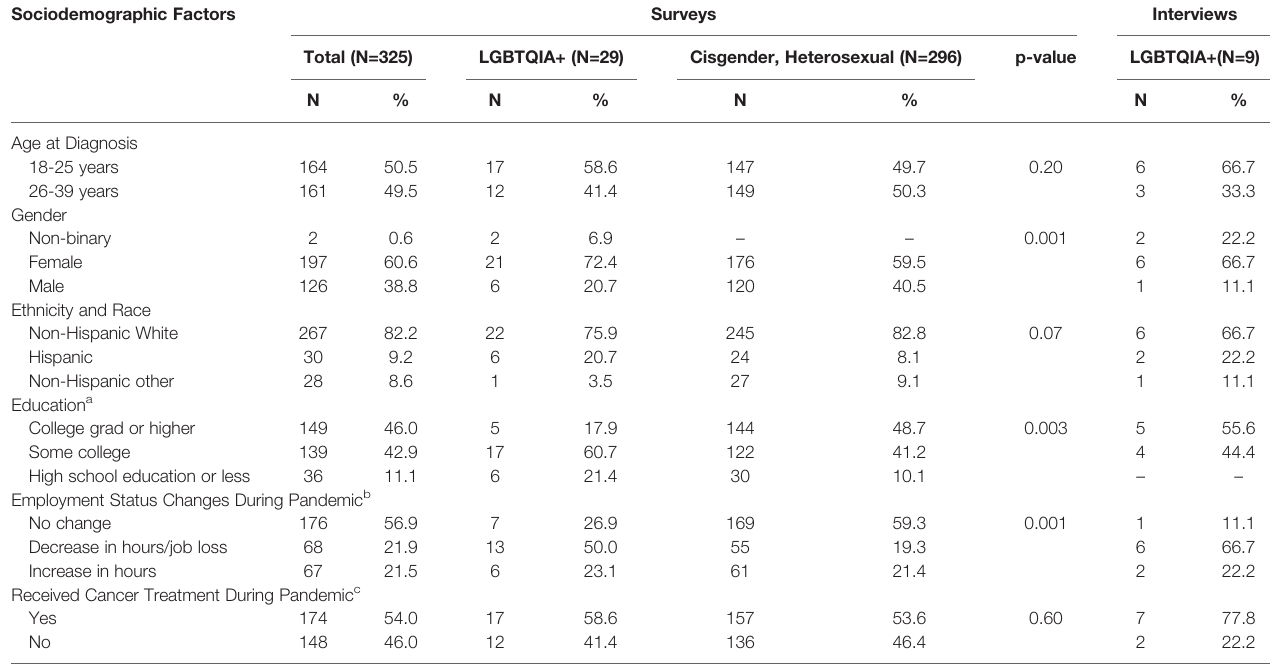
TABLE 1 | Characteristics of Quantitative Survey and Qualitative Interview Participants and Differences by LGBTQIA+ Status among Survey Participants (N=325). Sociodemographic